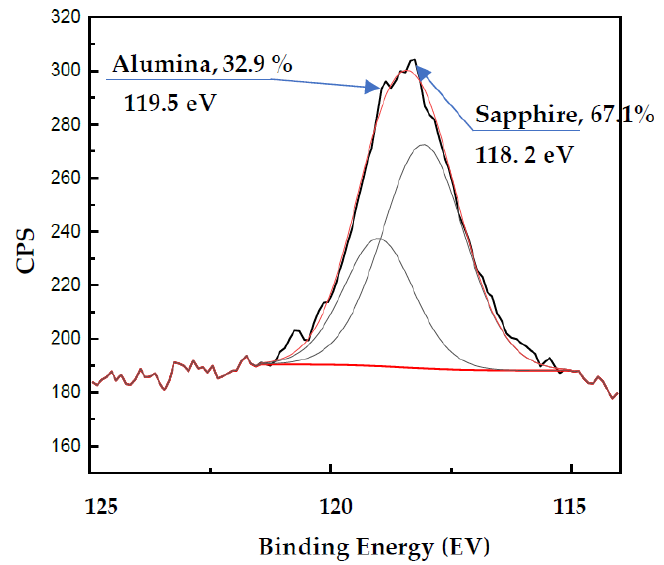
Figure 4. Typical XPS spectra (Al 2s) of the worn tool surface with a CVD alumina